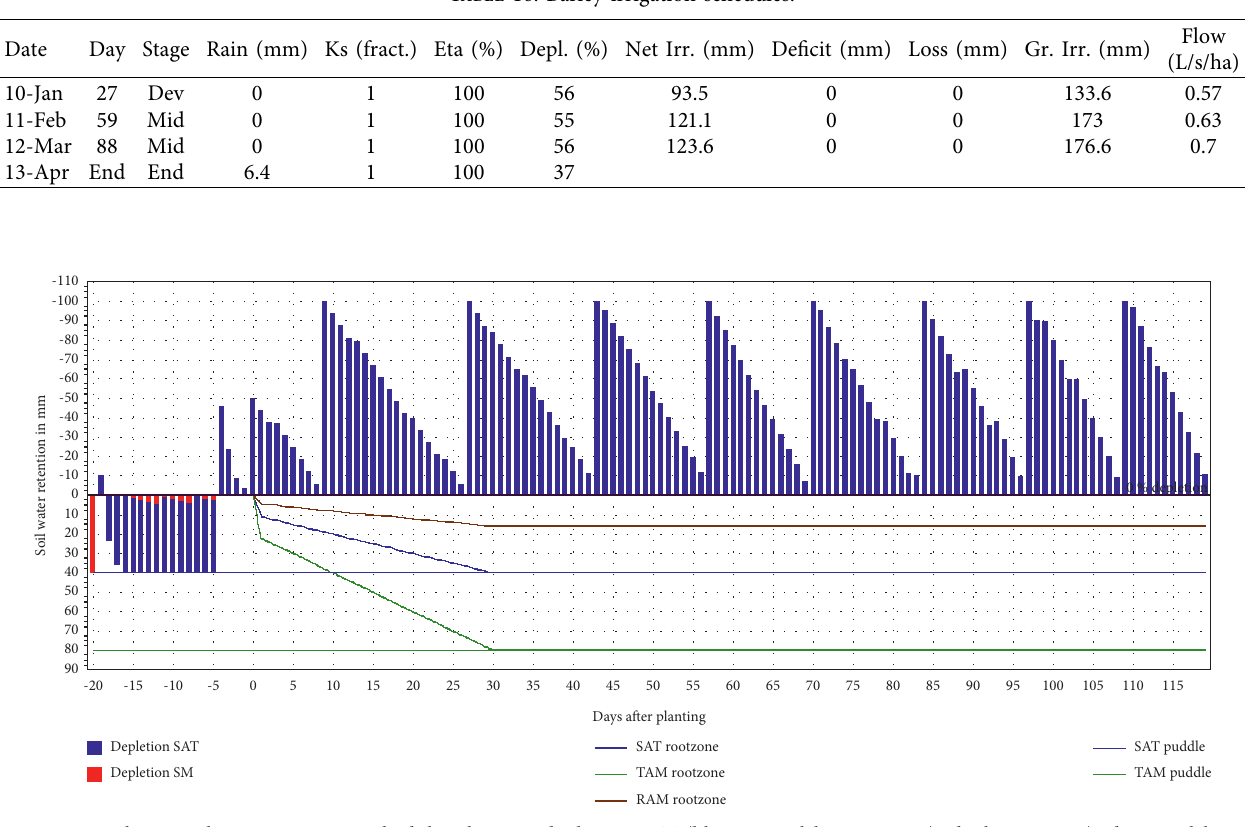
Figure 3: Color reveals rice irrigation schedules showing depletion SAT (blue vertical lines pattern); depletion SM (red vertical lines pattern); SAT rootzone (dark blue line); TAM rootzone (dark green line); RAM rootzone (brown line); SAT puddle (blue thin line); and TAM puddle (green thin